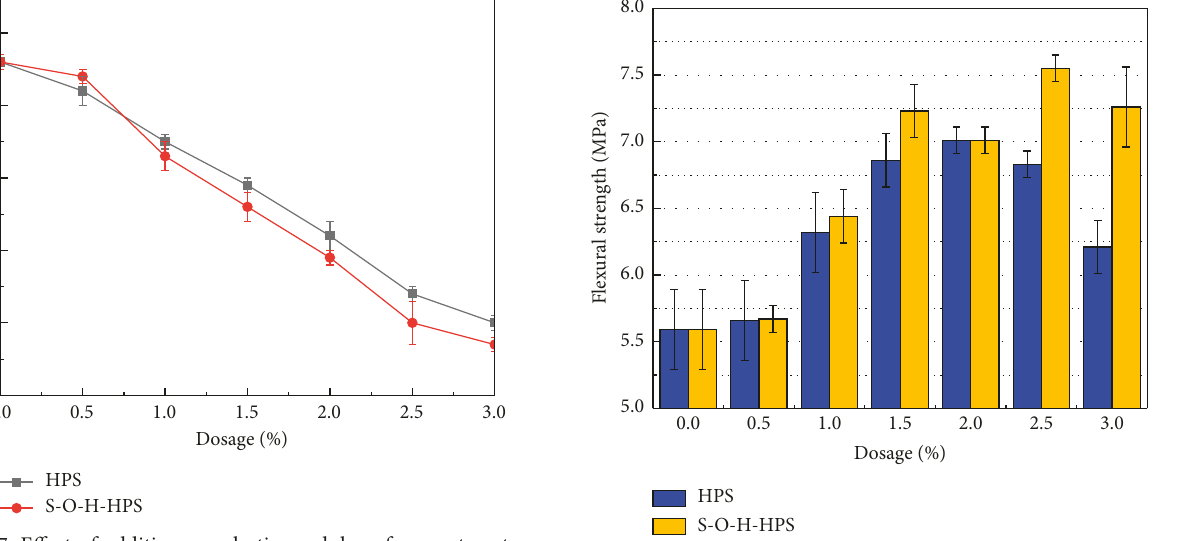
Figure 9: Effect of additives on shear strength of cement paste.